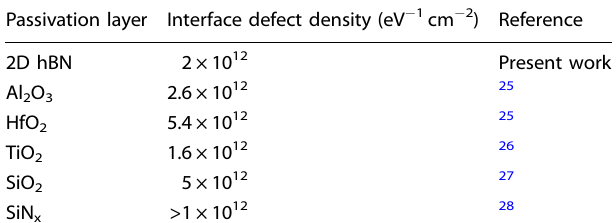
Table 2. Comparison of hBN passivation with other 3D passivation layers.